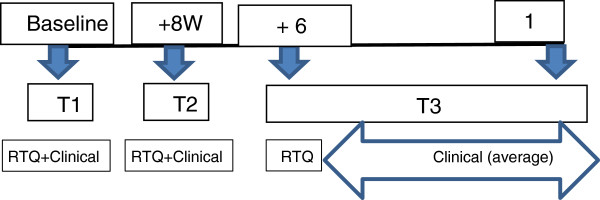
Study time periods.